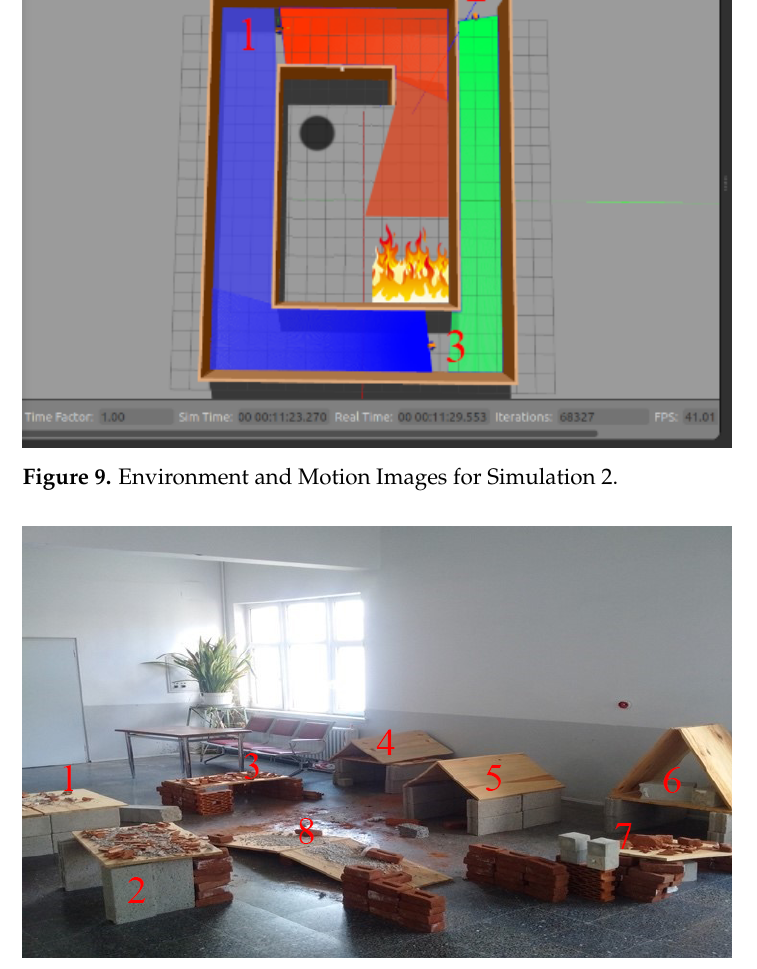
Figure 10. The Training Platform in